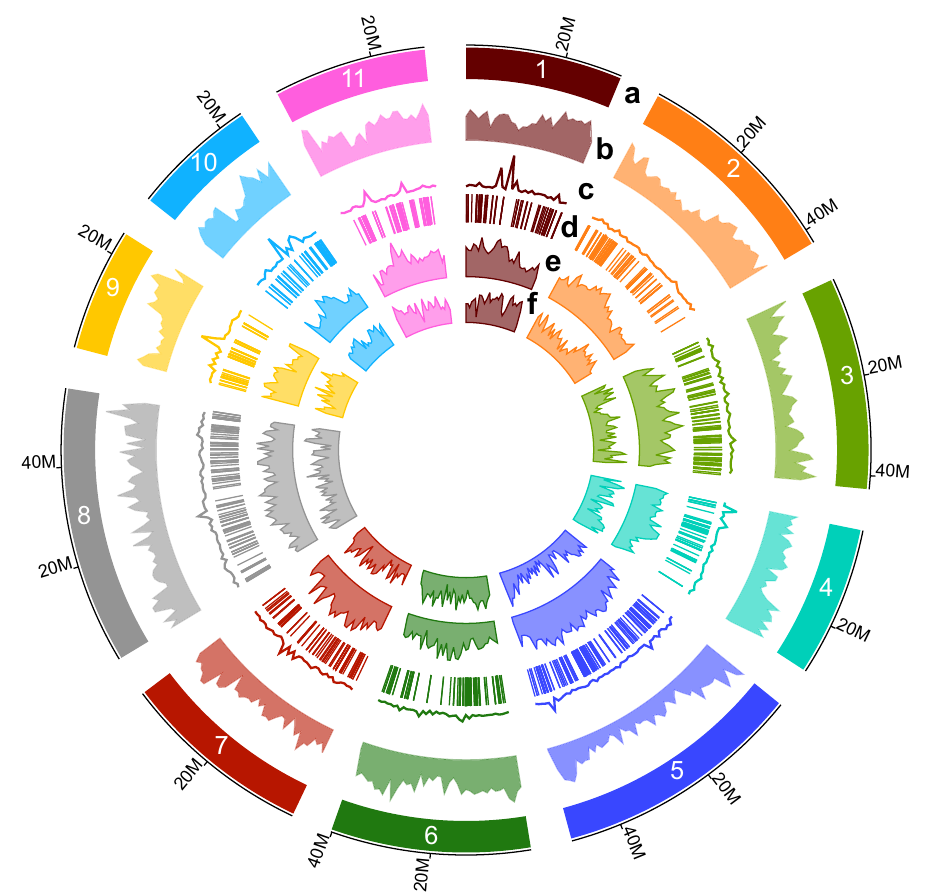
Fig. 1 Main genome features of Corymbia citriodora subspecies variegata (CCV). a The eleven chromosomes of CCV. Numbers along the outside track denote chromosome length in megabases. b Gene density (gene number per megabase; 5 – 143). c Average expression (rpkm; 0.5 – 150) among collected tissues for RNASeq per megabase. d Tandem gene arrays. e Percent repetitive content per megabase (5 – 61%). f Number of heterozygous SNPs per megabase (230 – 7,282). Table 1 Assembly and genome statistics for Corymbia citriodora subspecies variegata (v2.1- Phytozome v13) and Eucalyptus grandis (v2.0- Phytozome